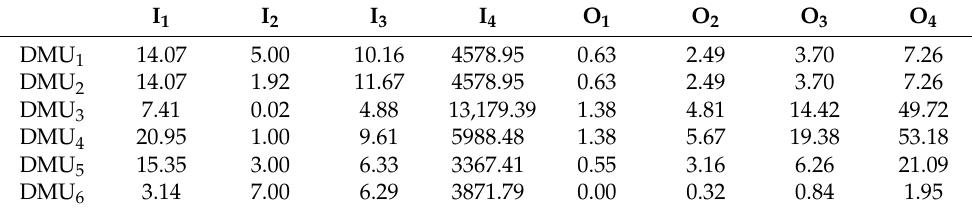
Table 6. Road section parameters in relation to input-output